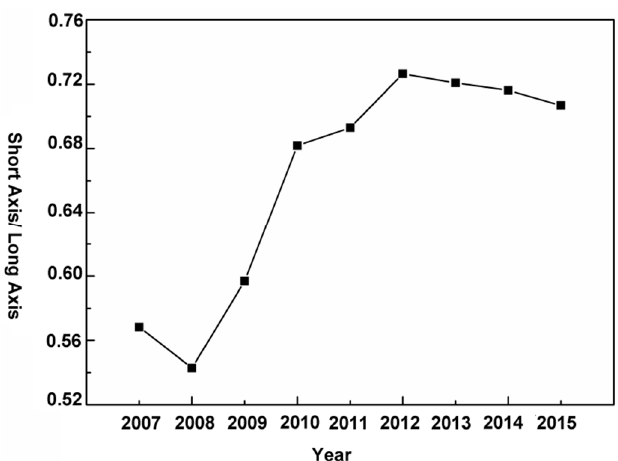
Figure 7. Changes in the SDE short axis/long axis ratio from 2007 to 2015.